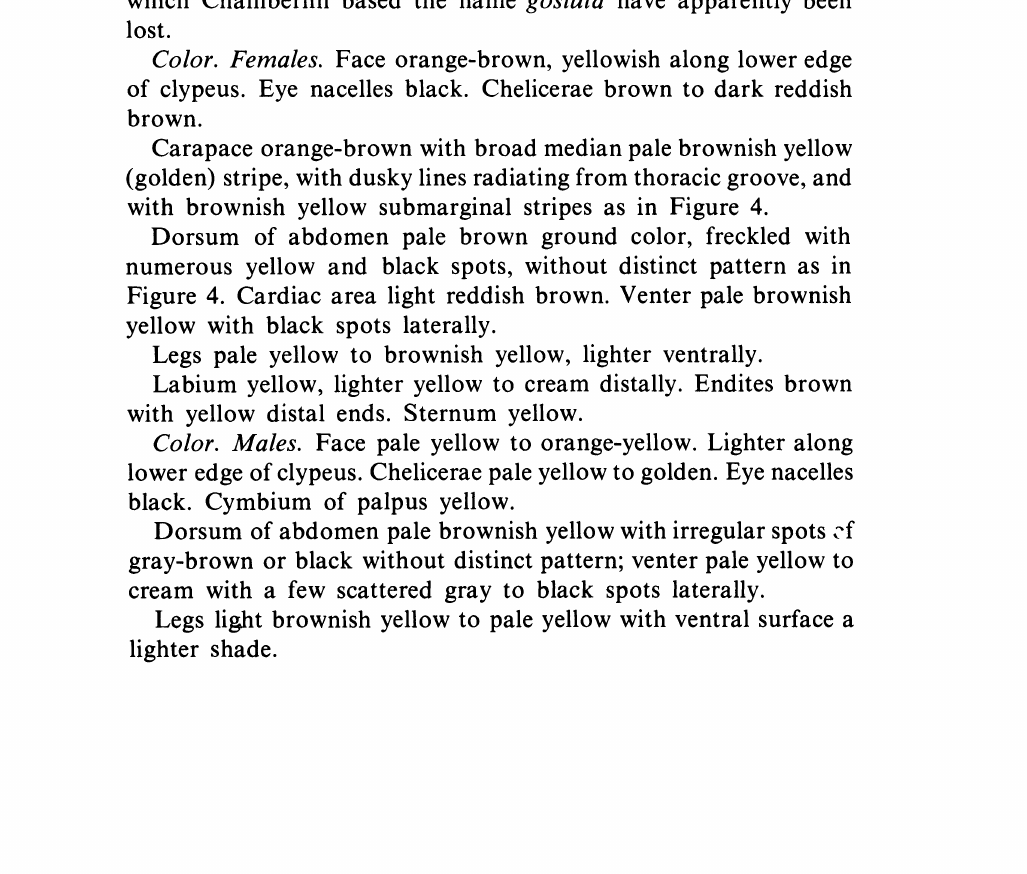
(1908) as a variety of avara. He indicated that females from Utah of this variety differed from avara in the shape of the epigynum. No type specimen was designated and the specimens from Utah upon which Chamberlinbased the name gosiuta have apparently been lost. Color. Females. Face orange-brown, yellowish along lower edge of clypeus. Eye nacelles black. Chelicerae brown to dark reddish brown. Carapace orange-brown with broad median pale brownish yellow (golden) stripe, with dusky lines radiating from thoracic groove, and with brownish yellow submarginal stripes as in Figure 4. Dorsum of abdomen pale brown ground color, freckled with numerous yellow and black spots, without distinct pattern as in Figure 4. Cardiac area light reddish brown. Venter pale brownish yellow with black spots laterally. Legs pale yellow to brownish yellow, lighter ventrally. Labium yellow, lighter yellow to cream distally. Endites brown with yellow distal ends. Sternum yellow. Color. Males. Face pale yellow to orange-yellow. Lighter along lower edge of clypeus. Chelicerae pale yellow to golden. Eye nacelles black. Cymbium of palpus yellow. Dorsum of abdomen pale brownish yellow with irregular spots gray-brown or black without distinct pattern; venter pale yellow to cream with a few scattered gray to black spots laterally. Legs lielat brownish yellow to pale yellow with ventral surface a lighter